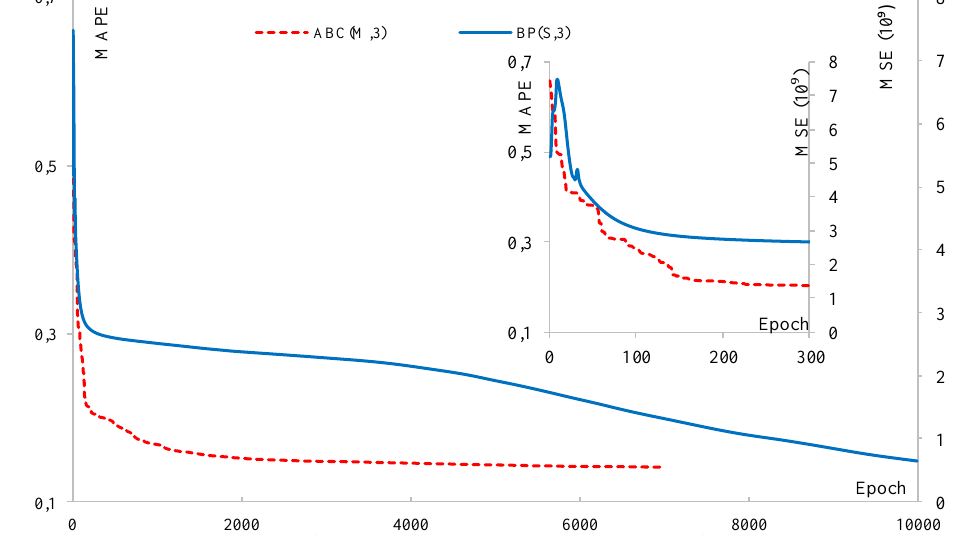
Figure 10. The best ANN structures of BP and ABC day-ahead forecasts for training